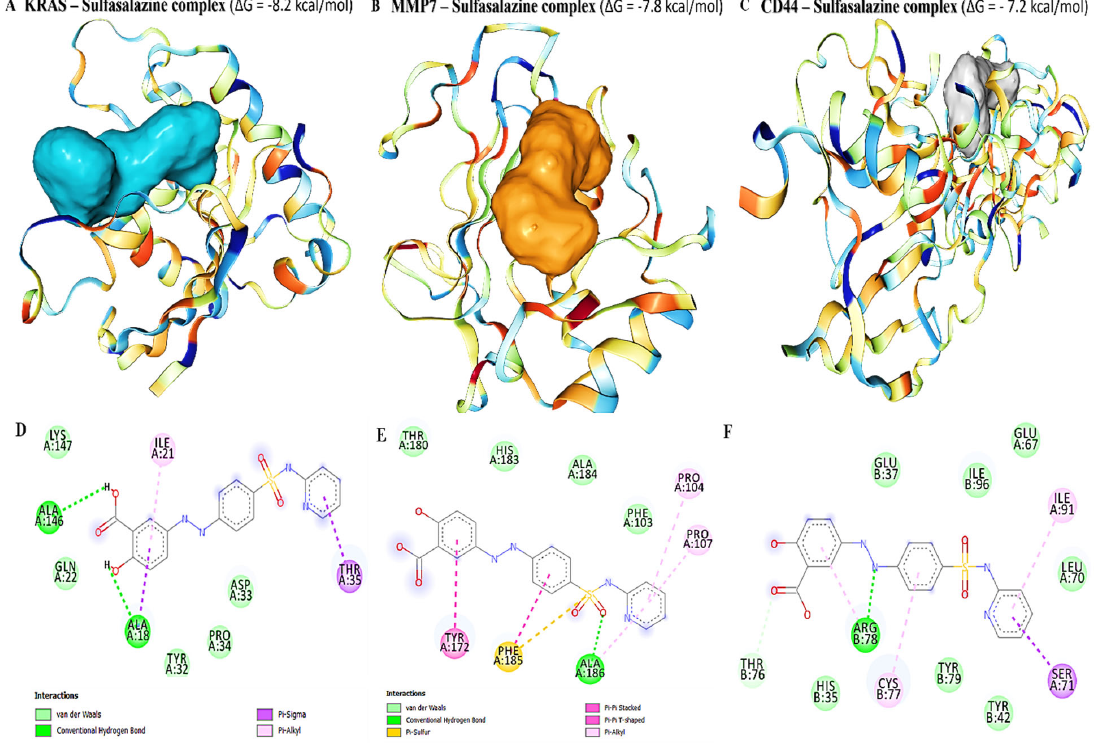
Figure 9. Sulfasalazine in complex with KRAS, MMP7 , and CD44 displayed putative binding interactions. ( A – C ) Binding interactions of KRAS , MMP7 , and CD44 , with sulfasalazine exhibited binding affinities of − 8.2, − 7.9, and − 7.2 kcal/mol, respectively. Moreover, the visualization analysis revealed interactions by conventional hydrogen bonds (H-bonds) with ALA145 and ALA18 for KRAS , ALA186 for MMP7, and ARG78 for CD44 . Interactions were further stabilized by van der Waals forces, π – π stacking interactions, and carbon-hydrogen bonds in the binding pockets of the receptors ( D – F ).